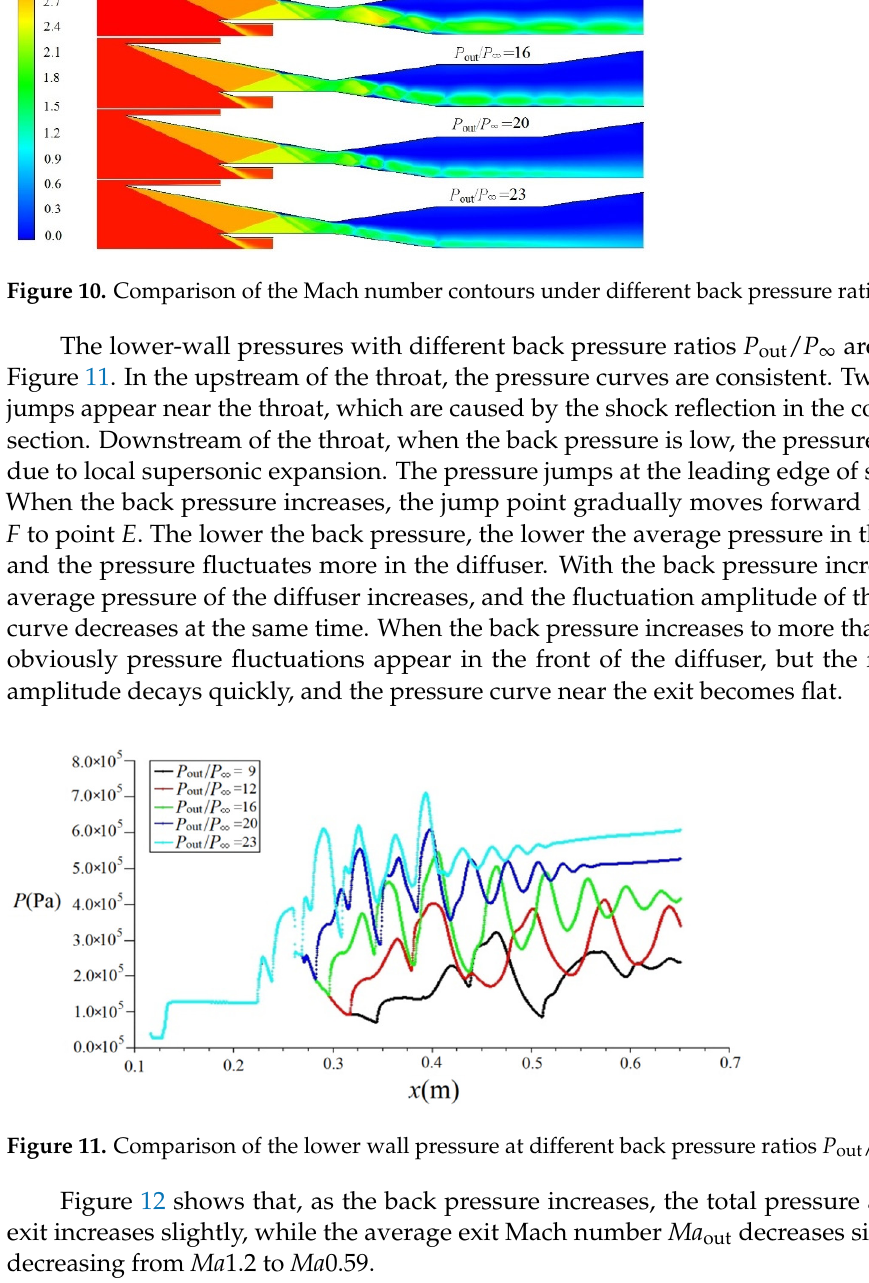
Figure 11. Comparison of the lower wall pressure at different back pressure ratios P out / P ∞ .